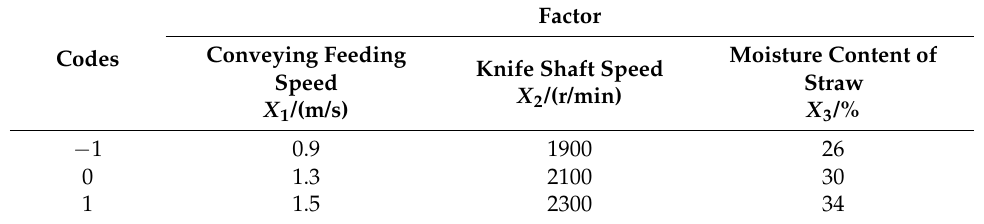
Table 2. Factors and levels of experiment.